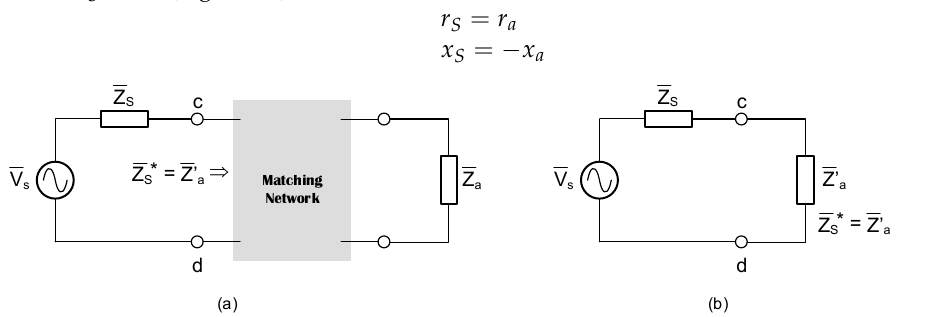
Figure 18. Source–load matching for maximum power transfer. ( a ) Principle circuit. ( b ) The equivalent load.